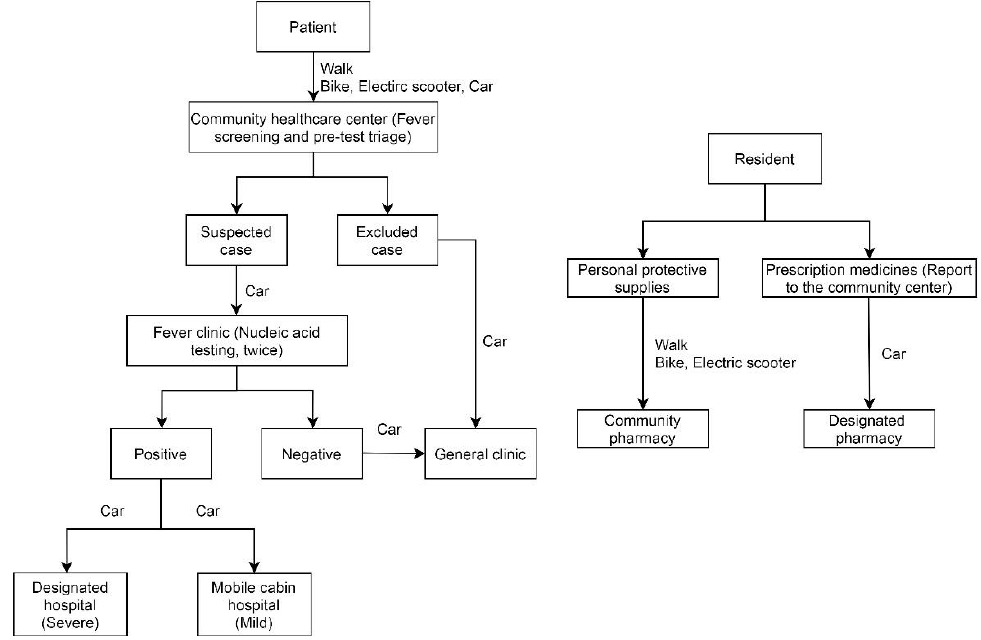
Figure 3. Treatment procedure, supply purchase, and travel modes of COVID-19 patients and resi- dents.